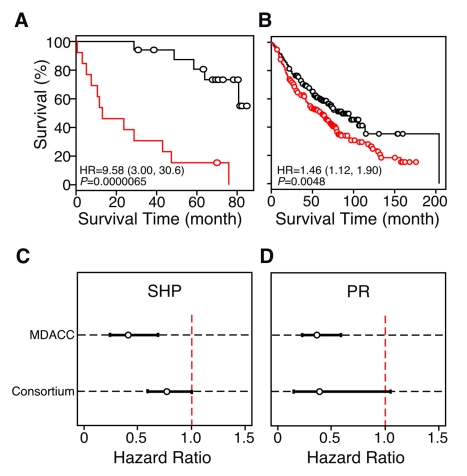
Identification of single NR gene biomarkers for lung cancer prognosis.(A and B) Kaplan-Meier survival plots using PR in the single gene prediction model. The MDACC cohort was tested using LOOCV (A), or it was used as a training set and independently tested in the multi-site Consortium cohort (B). For this analysis mRNA expression values for SHP were removed from the dataset in order to test the effect of other NR genes as biomarkers. In this case, PR expression is the single co-variable (or predictor) in the classification model that describes the survival time differences shown in (B), demonstrating that PR is a single gene predictor that represents the NR gene profile when SHP expression is excluded. p-values were obtained using the log-rank test. Red and black lines represent high- and low-risk groups, respectively. Circles indicate censored samples. (C and D) HRs from univariate Cox regression models for SHP and PR expression, respectively, in the MDACC and multi-site Consortium datasets.